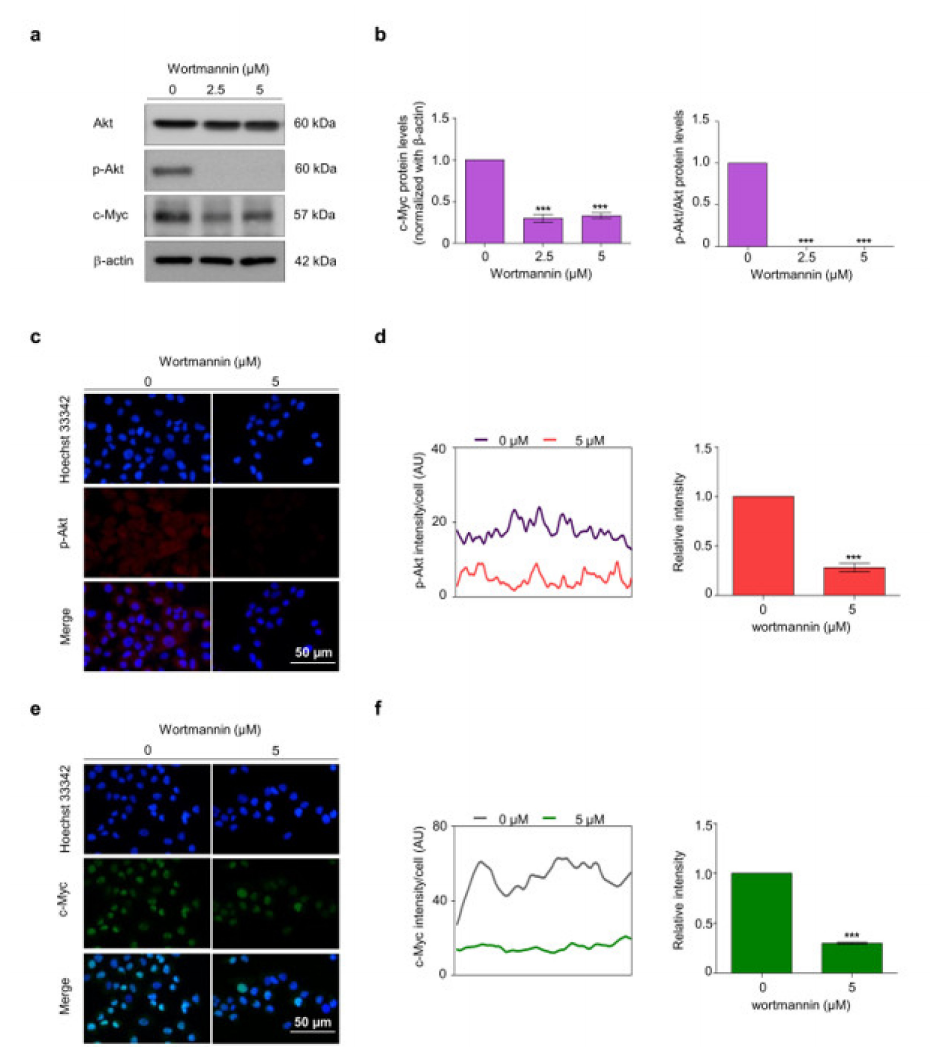
Figure 5. To demonstrate the relationship between the Akt signaling pathway and c-Myc, wortmannin, an Akt inhibitor, was used. ( a ) H460 cells were treated with 2.5 and 5 µ M of wortmannin for 12 h and the expression levels of Akt, p-Akt, and c-Myc were analyzed by Western blotting. ( b ) Levels of Akt, p-Akt, and c-Myc were analyzed by densitometric analysis. ( c , e ) H460 cells were treated with 5 µ M of wortmannin for 12 h. The treated cells were probed with anti-p-Akt and c-Myc. Hoechst33342 was used to identify nuclear localization. The expression of p-Akt and c-Myc were investigated using immunofluorescence. ( d , f ) The fluorescence intensity was analyzed using ImageJ software. Values are presented as means ± SEM ( n = 3). *** p < 0.001 compared with untreated